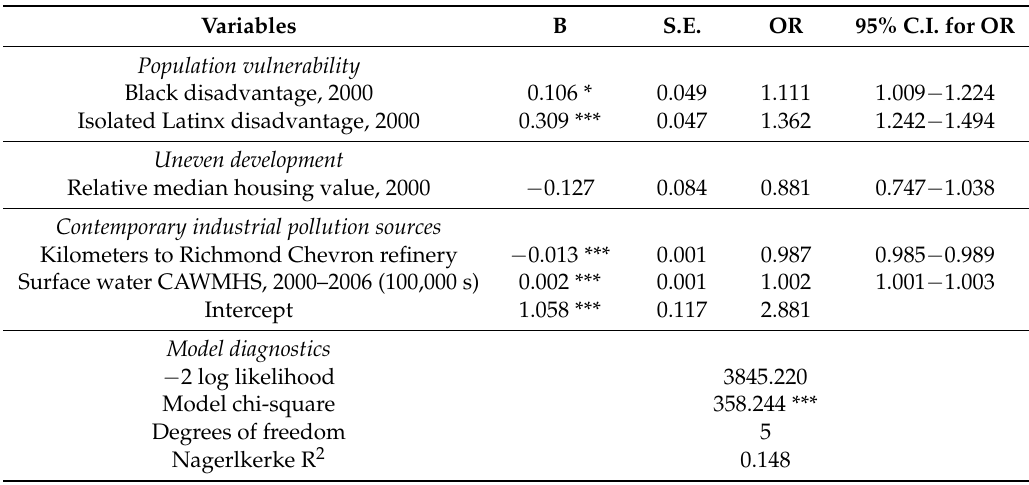
Table 7. GLR results for block group 50 percent areal containment within a 2006, 303(d), impaired water hazard zone on population vulnerability, uneven development, and contemporary industrial pollution sources ( N = 3401 block